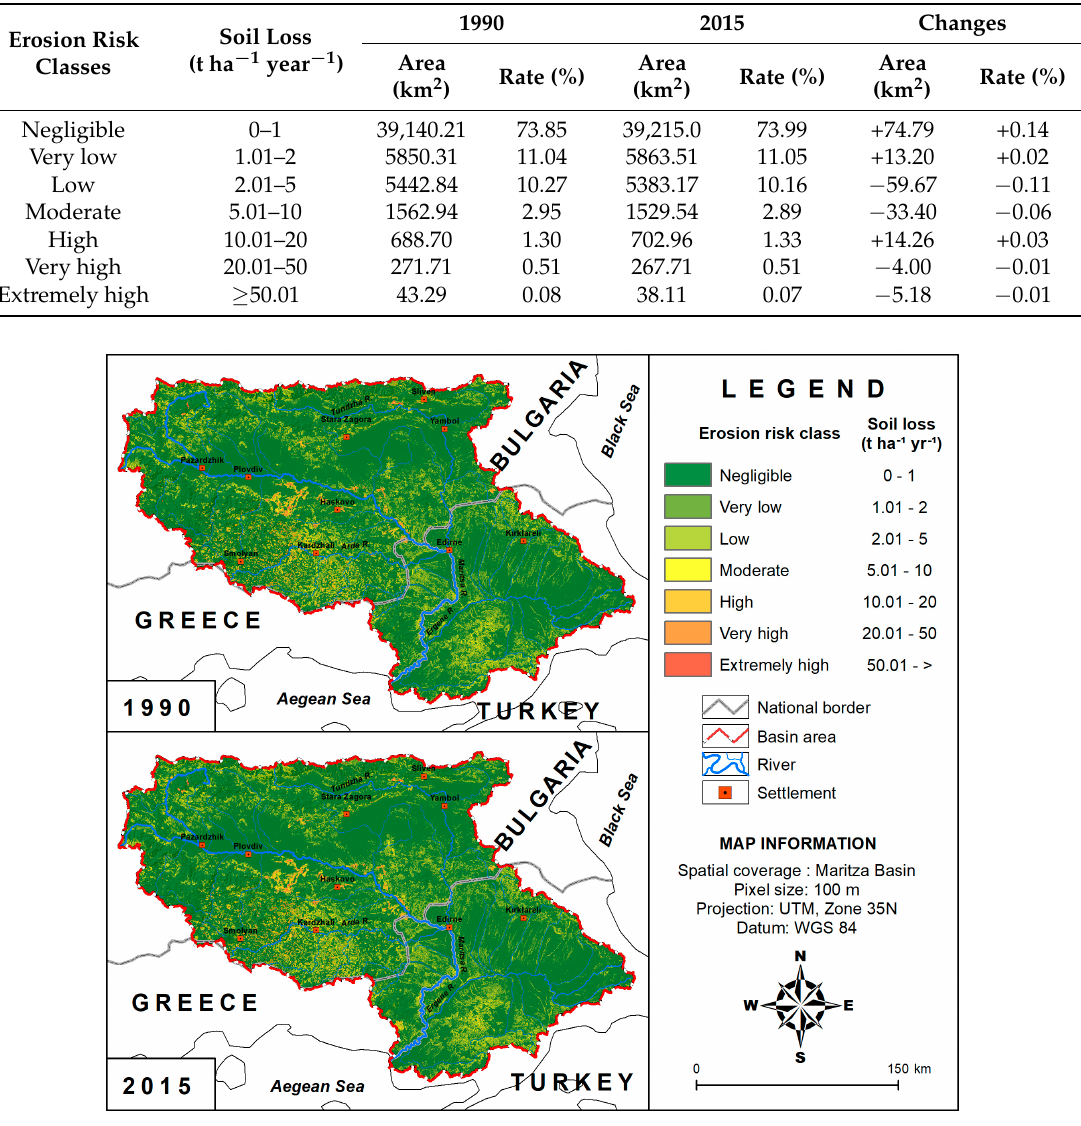
Figure 7. Map of soil loss rates in the Maritsa Basin based on RUSLE.